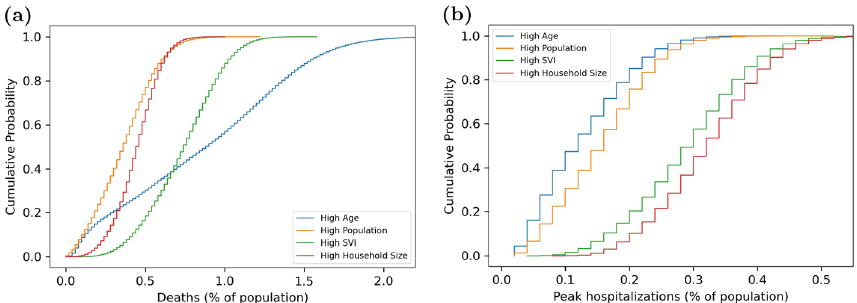
Fig. 6 Empirical cumulative distribution of a deaths and b peak hospitalization for each community